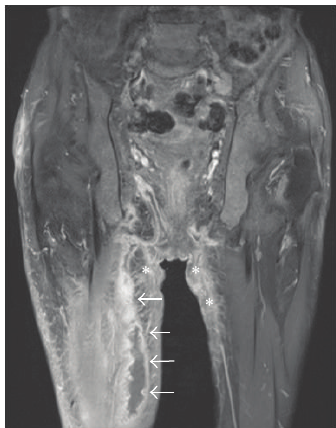
Figure 3: Coronal T1-weighted fat-suppressed image postcontrast shows inferior extension of the rim-enhancing abscess along the medial aspect of the right thigh (white arrows). Note: associated bilateraldermalindurationbestseenintheperineumwithabnormal enhancement ( ∗